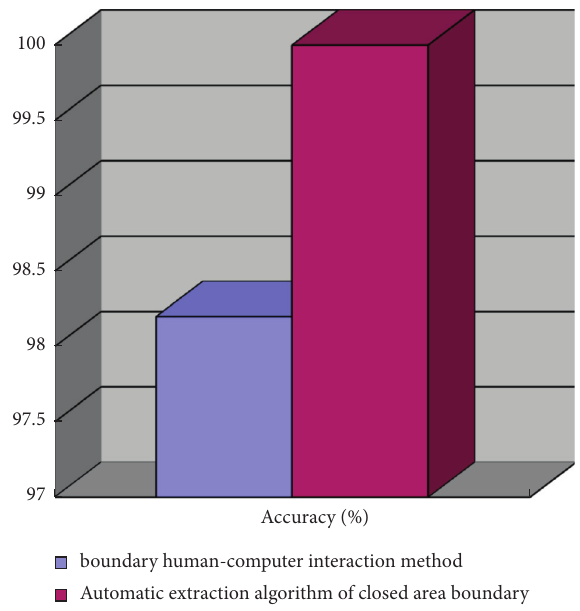
Figure 8: Comparison of accuracy of boundary extraction